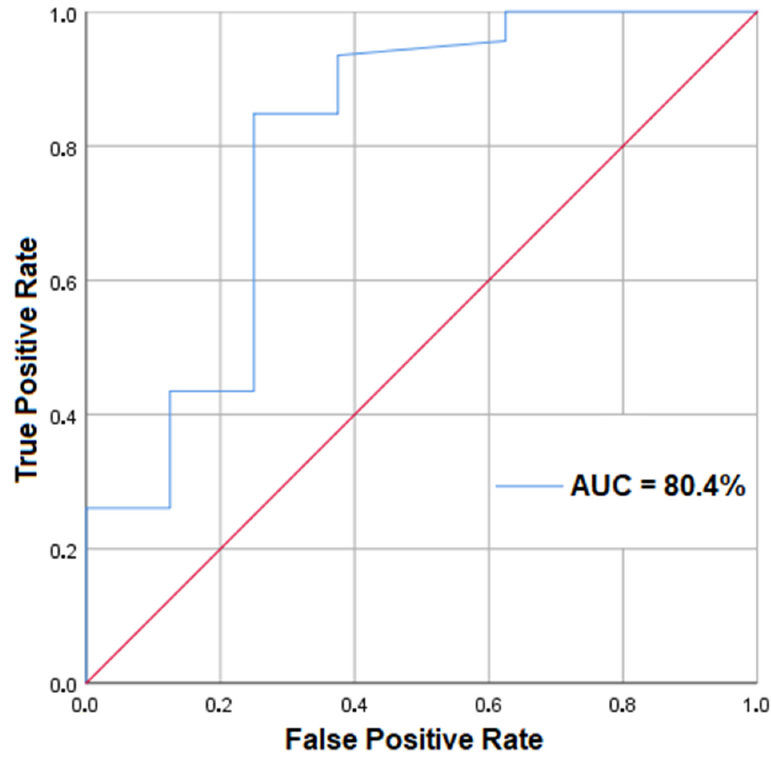
Figure 8. ROC curves of GWPM using AHP.